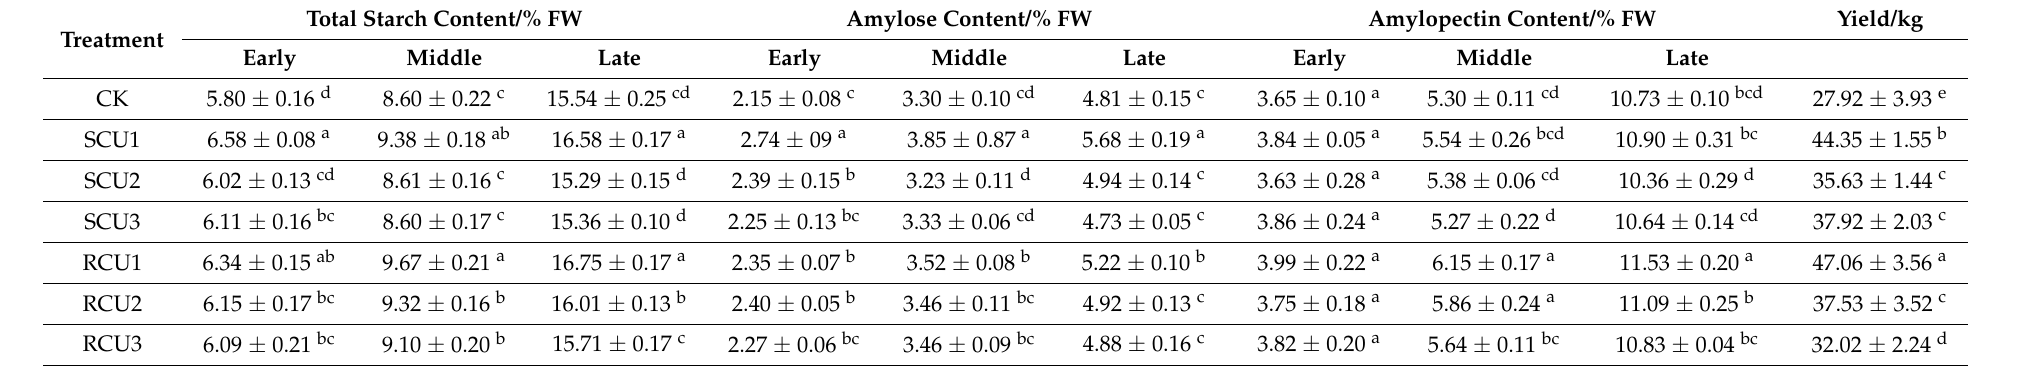
Table 2. Starch content and yield under SCU and RCU